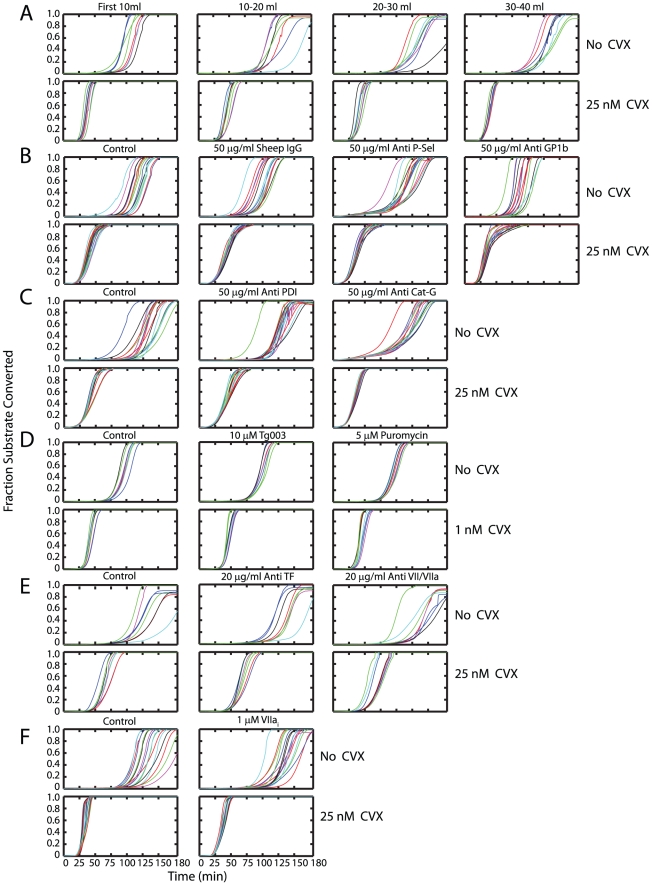
Evaluating mechanisms that could lead to initiation of clotting of blood drawn into CTI without exogenous TF addition.(A) To evaluate the effect of phlebotomy, experiments were conducted ±CVX using the first 10 mls, 10–20 mls, 20–30 mls and 30–40 mls of blood. No steady increase in T
i was noted showing that TF from phlebotomy was not leading to eventual initiation. (B) Addition of antibodies against P-selectin or Gp1bα did not prolong initiation either in the absence or presence of high dose CVX, (C) Addition of antibodies against PDI or cathepsin G did not prolong initiation either in the absence or presence of high dose CVX. (D) The ribosome inhibitor puromycin; the Clk1 kinase inhibitor Tg003; (E) antibodies against TF, VII/VIIa; or (F) VIIai did not prolong initiation either in the absence or presence of high dose CVX. This shows that initiation is unaffected by either ‘bloodborne’ or platelet synthesized TF on the time scales of our experiments.